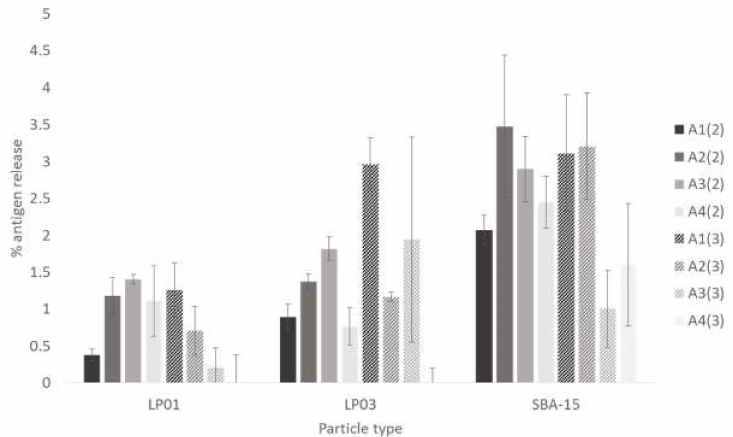
Figure 5. Determination of toxoid leached from silica nanoparticles. The supernatant was assayed to determine the protein leached under various di ff erent storage conditions. The samples were kept under the following conditions (A1) in suspension, kept at 4 ◦ C; (A2) in suspension, kept at RT; (A3) lyophilized, kept at 4 ◦ C; (A4) lyophilized, kept at RT. Numbers in brackets indicate incubation for either (2) two months, or (3) three months. Data shown is mean ± standard deviation.